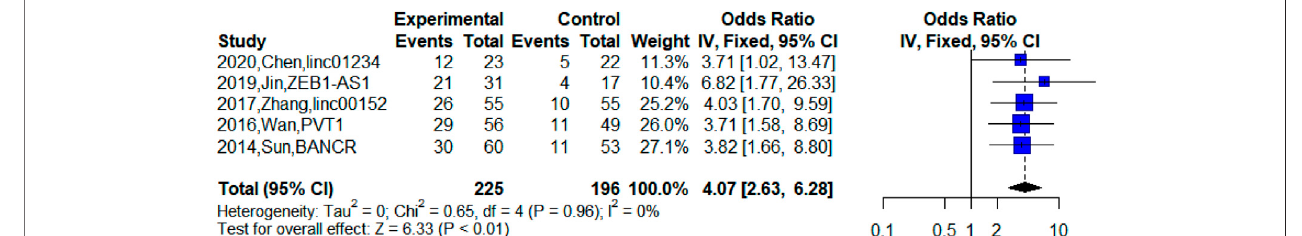
FIGURE 3 | Forest plots of the relationship between TNM Ⅲ a stage and the lncRNA expression level.